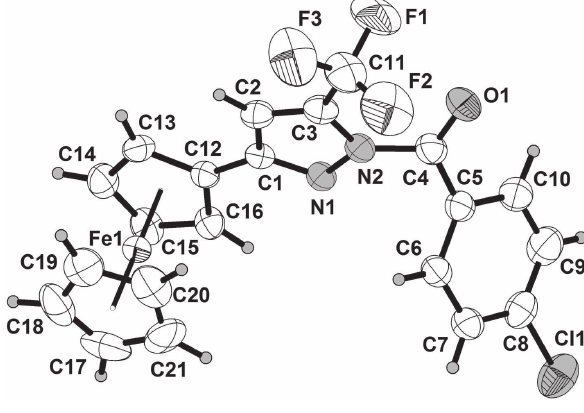
Table 1: Data collection and